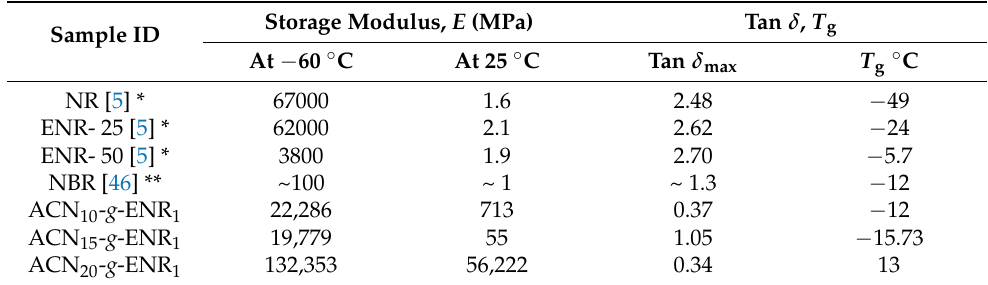
Figure 6. Storage modulus and tan δ as a function of temperature for ACN- g -ENR products at different mole ratios. Table 3. Storage modulus and tan δ of ENR- 25 and ACN- g -ENR products at different mole